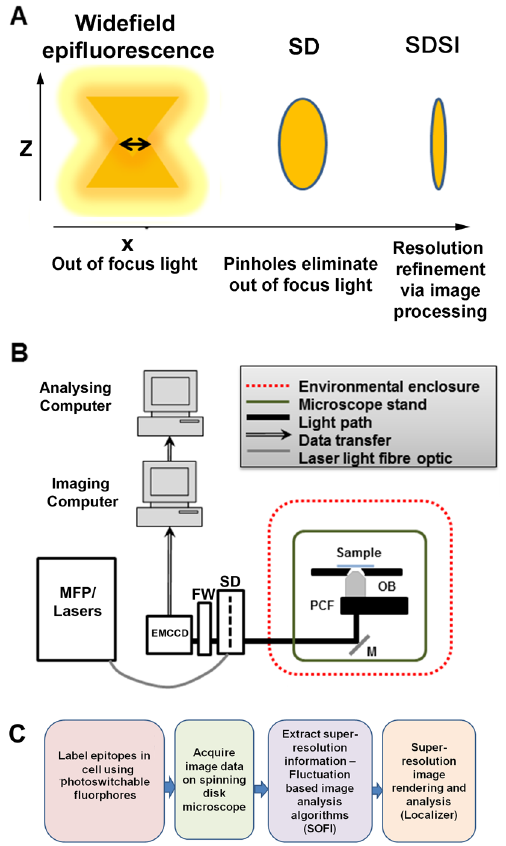
Figure 1. Setup of spinning disk stochastic imaging (SDSI) system and evaluation of imaging capabilities. (A) Schematic diagram describing how the point spread function is refined in a selected axial plane by spinning disk confocal microscopy and super- resolution image processing. (B) Diagram showing the configuration of the SDSI microscope, abbreviations are as follows. EMCCD=Electron multiplied Charge Coupled Device camera. FW=Filter wheel. SD=Yo- kagawa CSUX1 spinning disk, M=mirror. PCF=Piezo coupled focus feedback unit. OB=Objective. (C) Workflow of the SDSI experiments used in this paper, Briefly samples are prepared with probes for either PALM or dSTORM, next samples are imaged and finally SR data is generated using the SOFI image processing